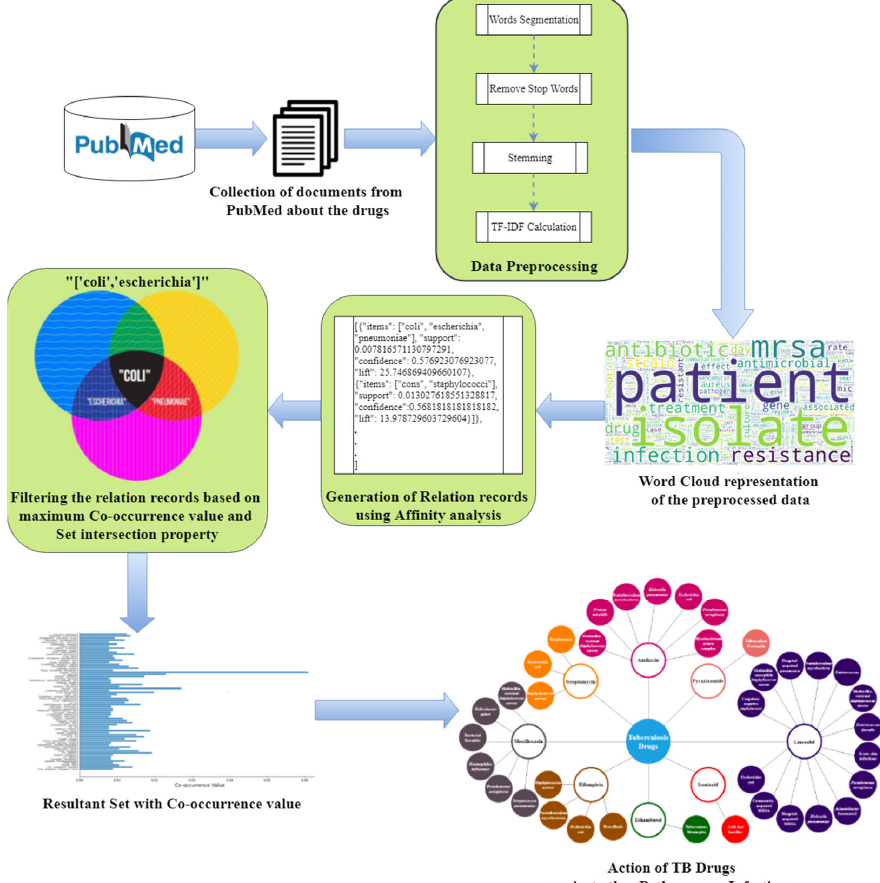
Figure 1. TREASURE framework for the analysis of TB drugs.